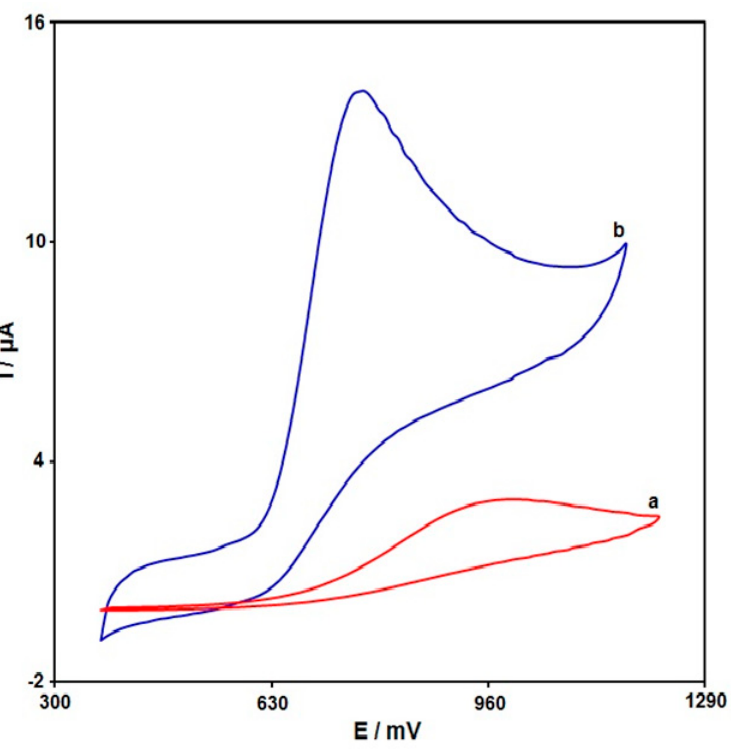
Figure 4. The CV curves for (curve a) unmodified SPE, and (curve b) MoS 2 NSs-SPE in PBS (0.1 M) spiked with INZ (200.0 µM) at the scan rate of 50 mV/s.